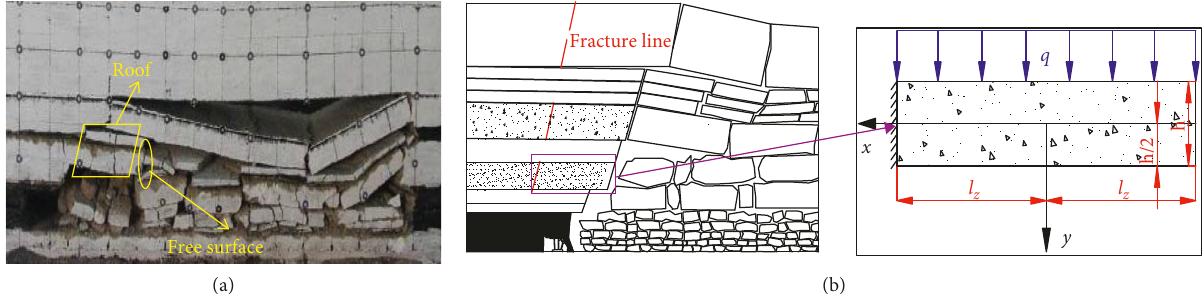
Figure 4: Load-bearing characteristics of the roof structure with cantilever supported condition.